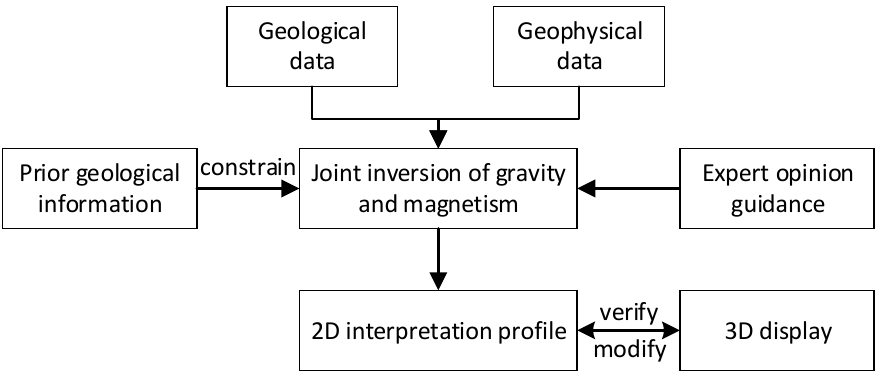
Figure 4. Gravity and magnetic inversion interpretation and profile-verification flow chart.